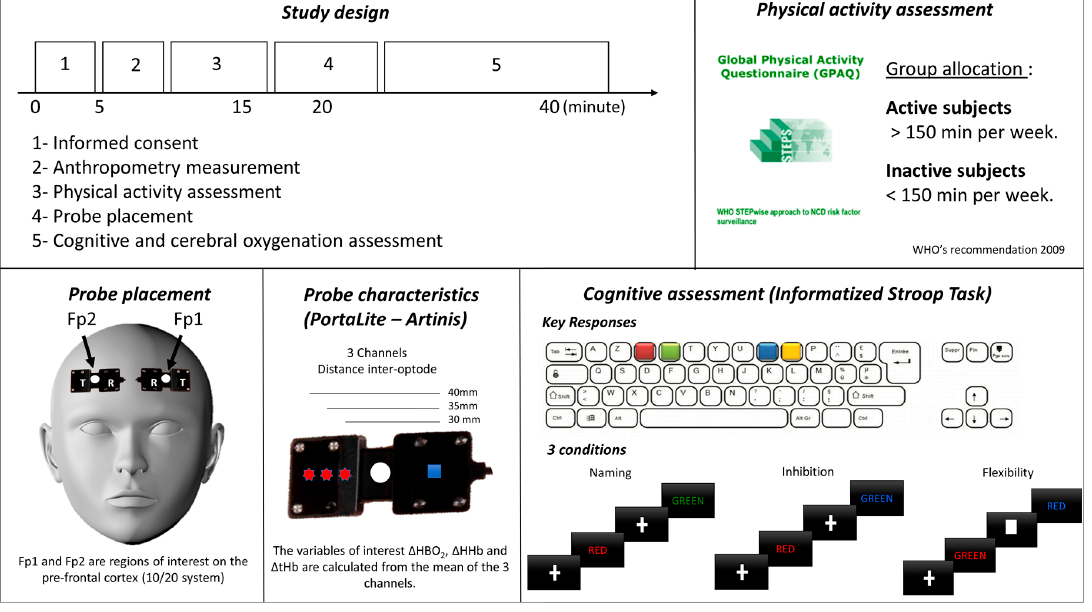
Figure 1. Study design and methodological information.